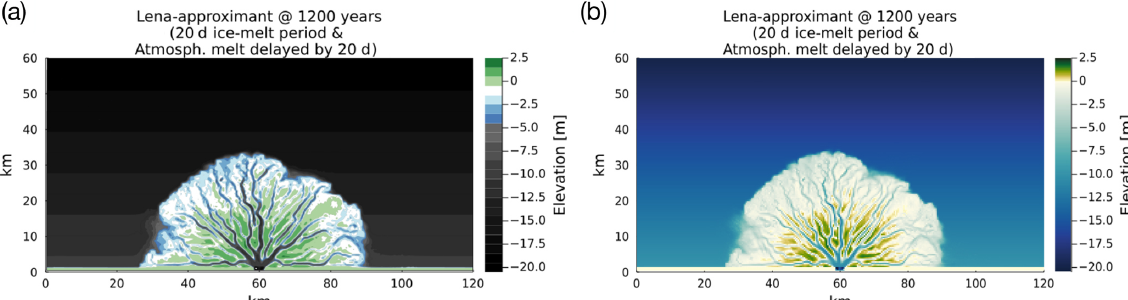
Figure 10. A delta produced by ArcDelRCM.jl after 1200 model years with configurations identical to those in Fig. 9d but with the low sediment-to-water volume ratio observed (Boike et al., 2019) and with a tilted ocean-basin bed motivated by the bathymetry of the Laptev Sea coast near the Lena Delta (see text in Sect. 3.4 for details). The panels show (a) the filled-contour view and (b) the gradient-coloured view of the same bed elevations. The latter is to facilitate visual comparisons with Fig.